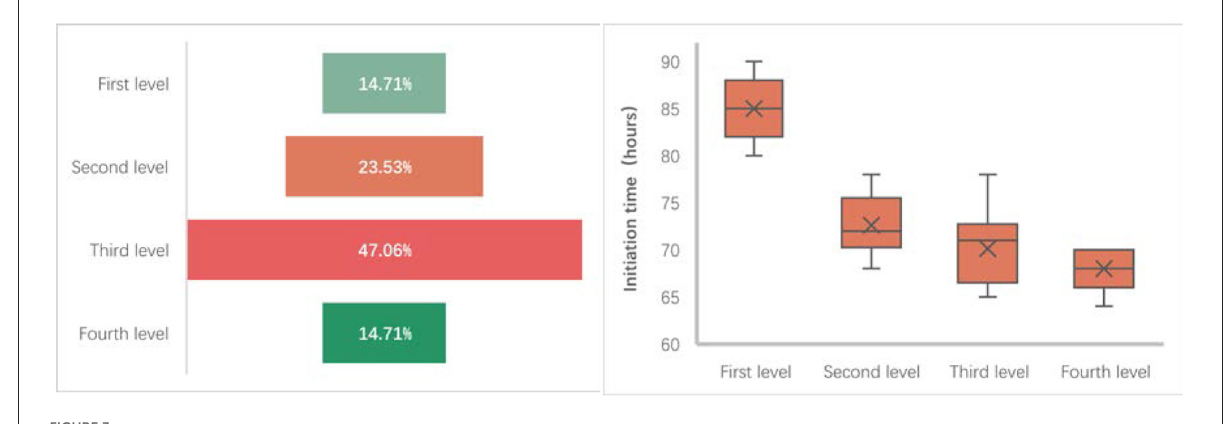
FIGURE3 Participation rate and initiation time in mobilization